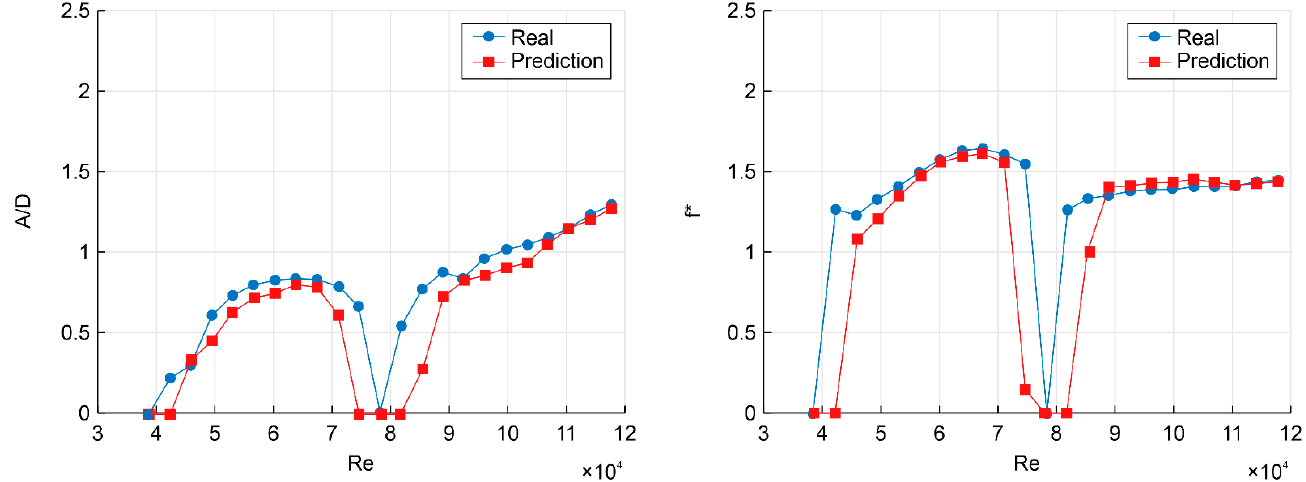
Figure 13. Cylinder amplitude (left) and frequency (right) with the real/predicted values for ζ harness = 0.16; K = 1000 N/m.